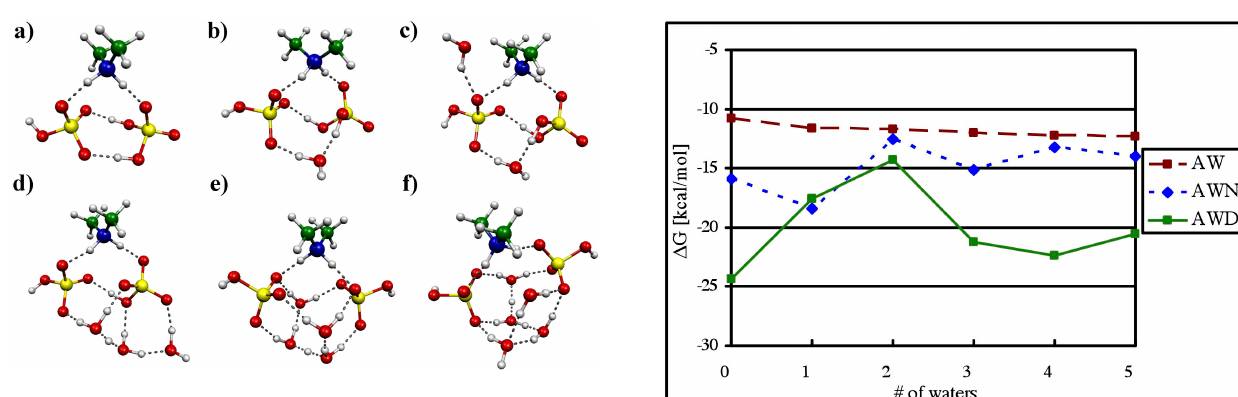
Fig. 6. The most stable structures with respect to the formation free energy 1G (at T = 298 . 15K and P = 1atm) for clusters consisting of two sulfuric acids with dimethylamine and 0–5 water molecules: Fig. 7. The free energy change 1G of addition of one H 2 SO 4